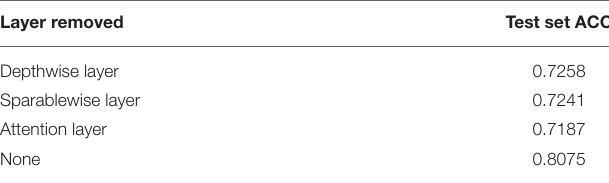
TABLE 3 | The result of model ablation